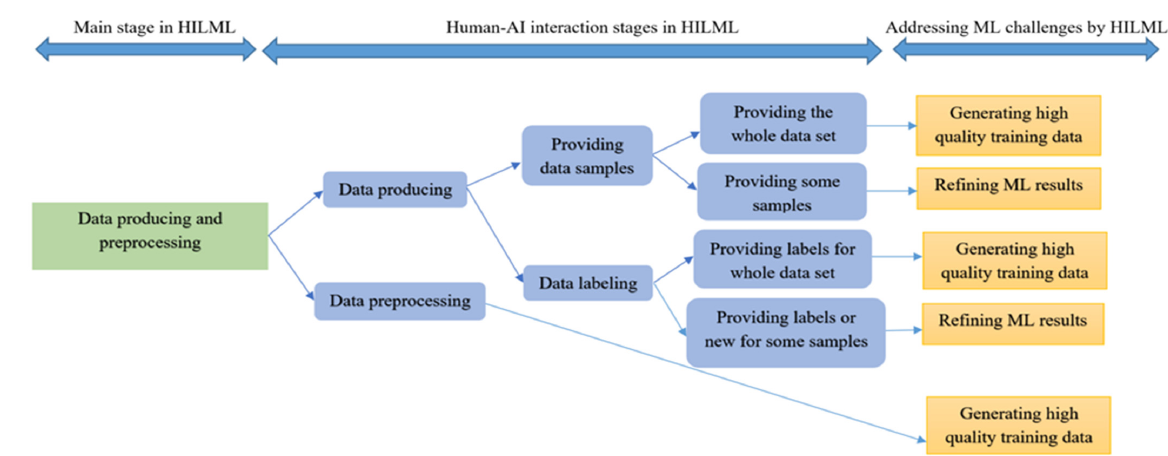
Figure 1. A framework overview of human–AI interaction in data producing and pre-processing.